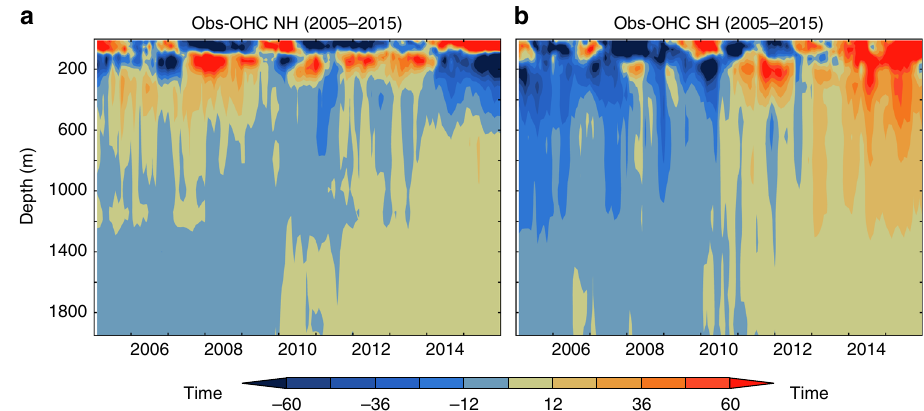
Fig. 1 Temporal variations of 0 – 2000 m ocean heat content anomaly. Hovmöller plot of observed ocean heat content anomaly (10 18 J m − 1 ) in 0 – 2000m ocean depth referenced from 2005 – 2015 for ( a ) northern hemisphere and ( b ) southern hemisphere.